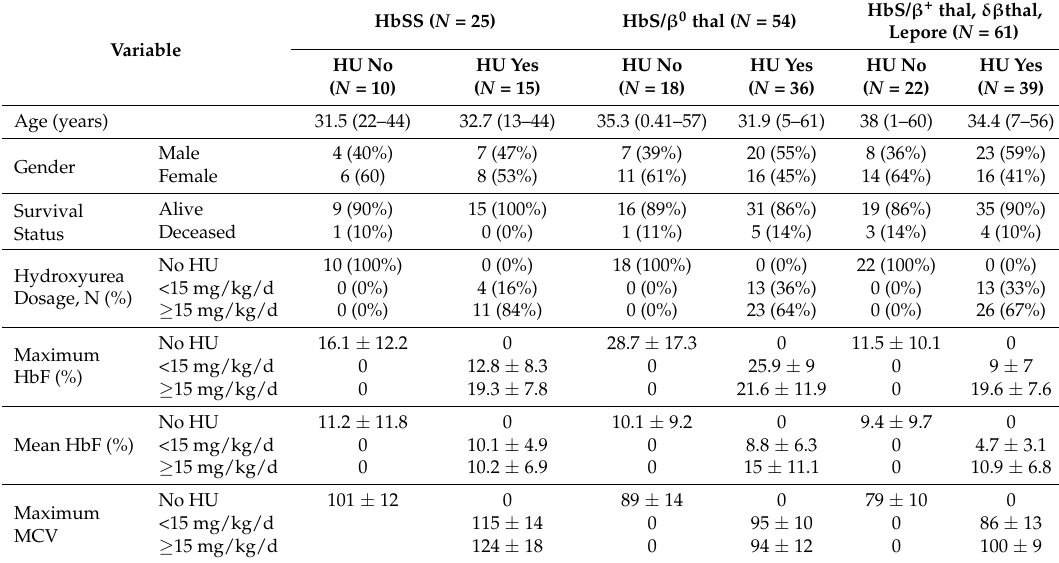
Table 2. Patient characteristics and hydroxyurea use among sickle phenotypes at last clinic